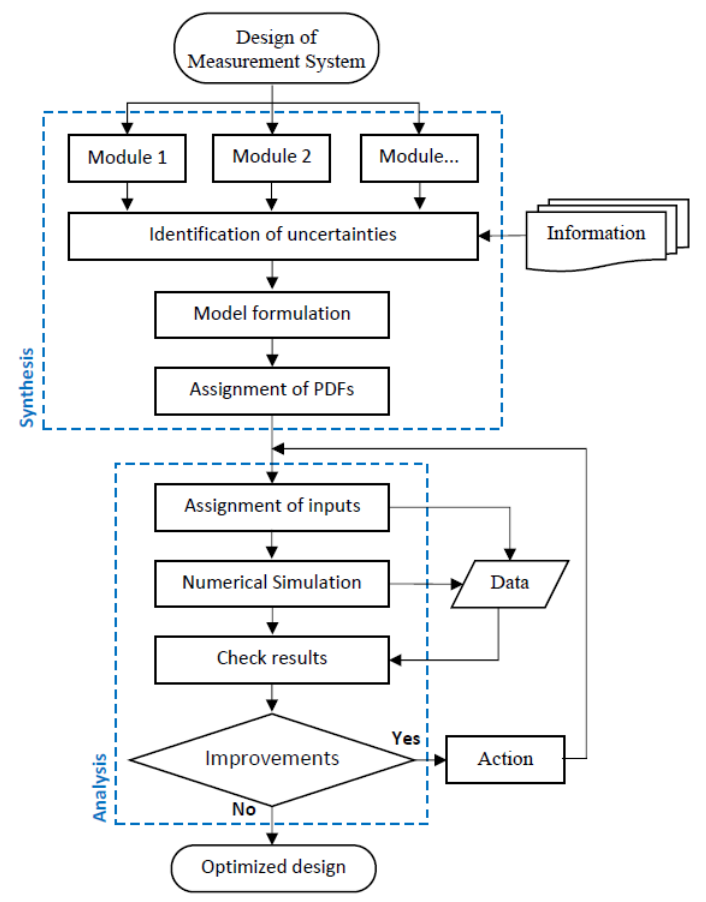
Figure 3. The sequence of stages involved in the synthesis and analysis phases of the proposed